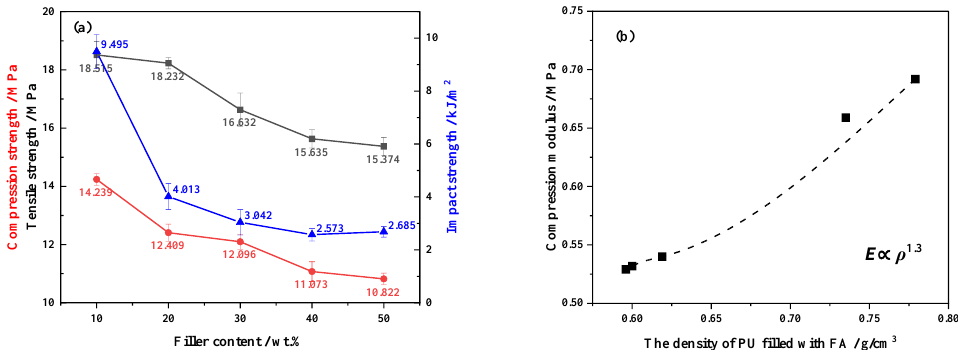
Figure 9. ( a ) The mechanical properties of PU/FA composites; ( b ) compression modulus as a function of density.